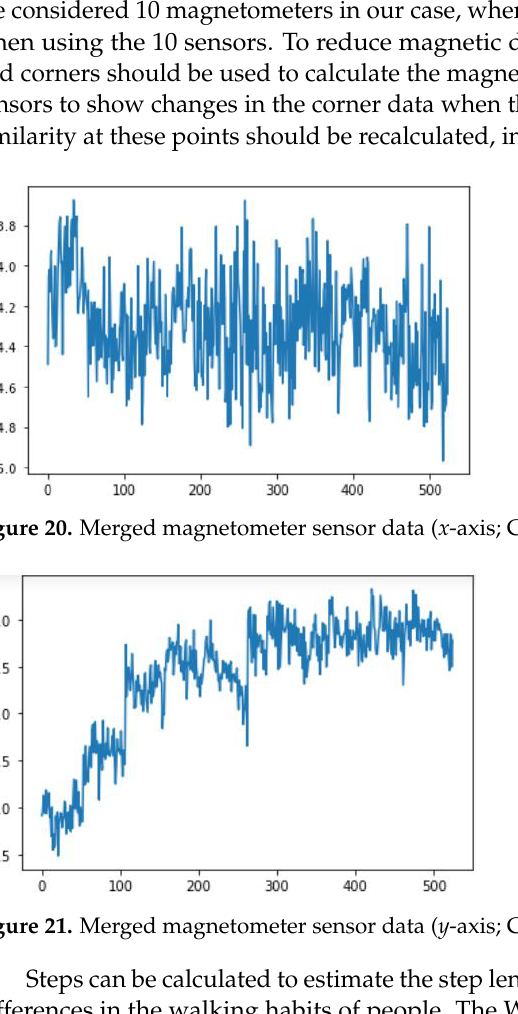
Figure 19. Magnetometer z -axis noise (CCIS/KSU).